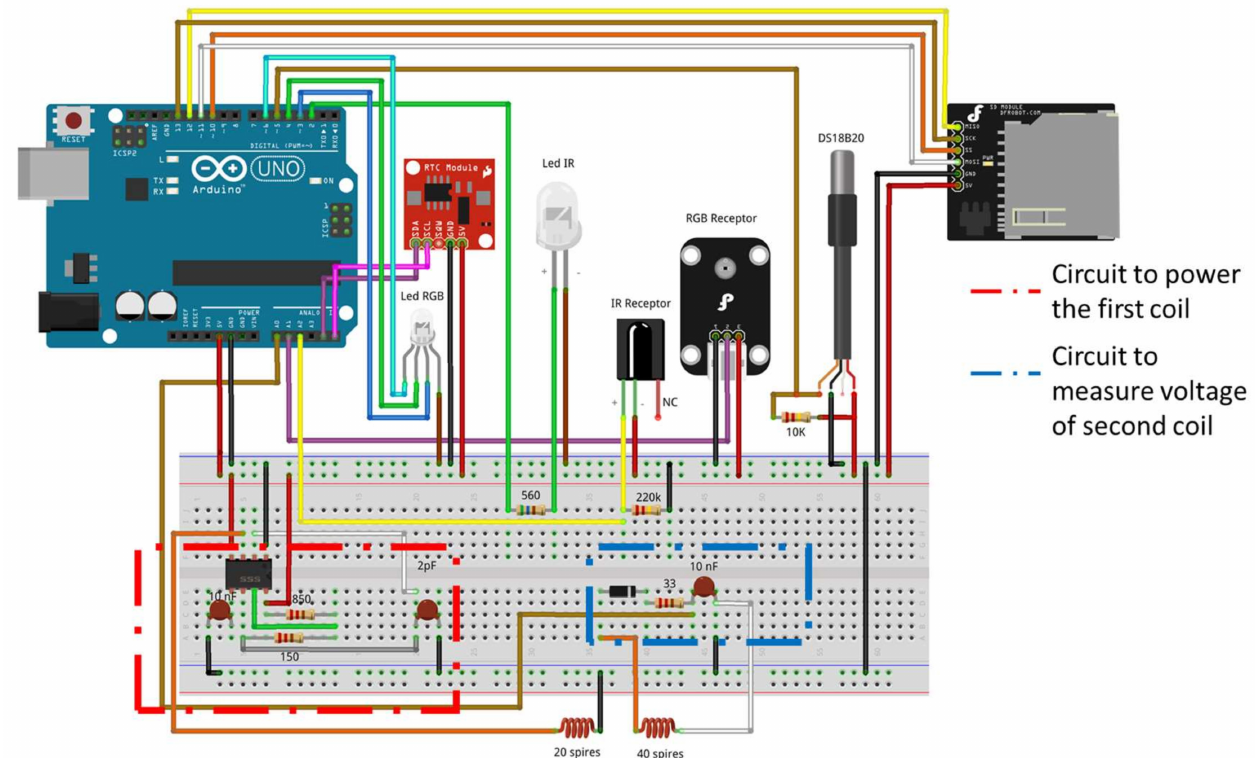
Figure 5. Full circuit of our sensor